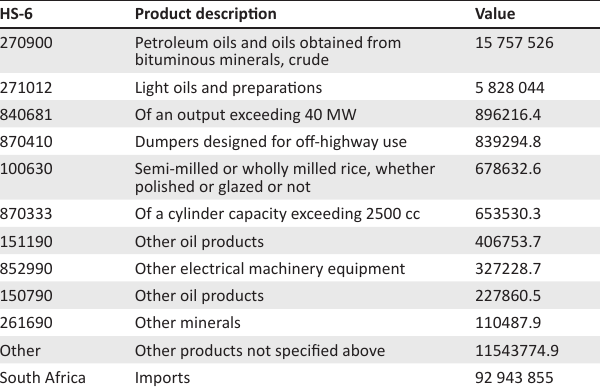
TABLE 10: South Africa’s top 10 imports from the European Union Free Trade Agreement (US$ 1000).